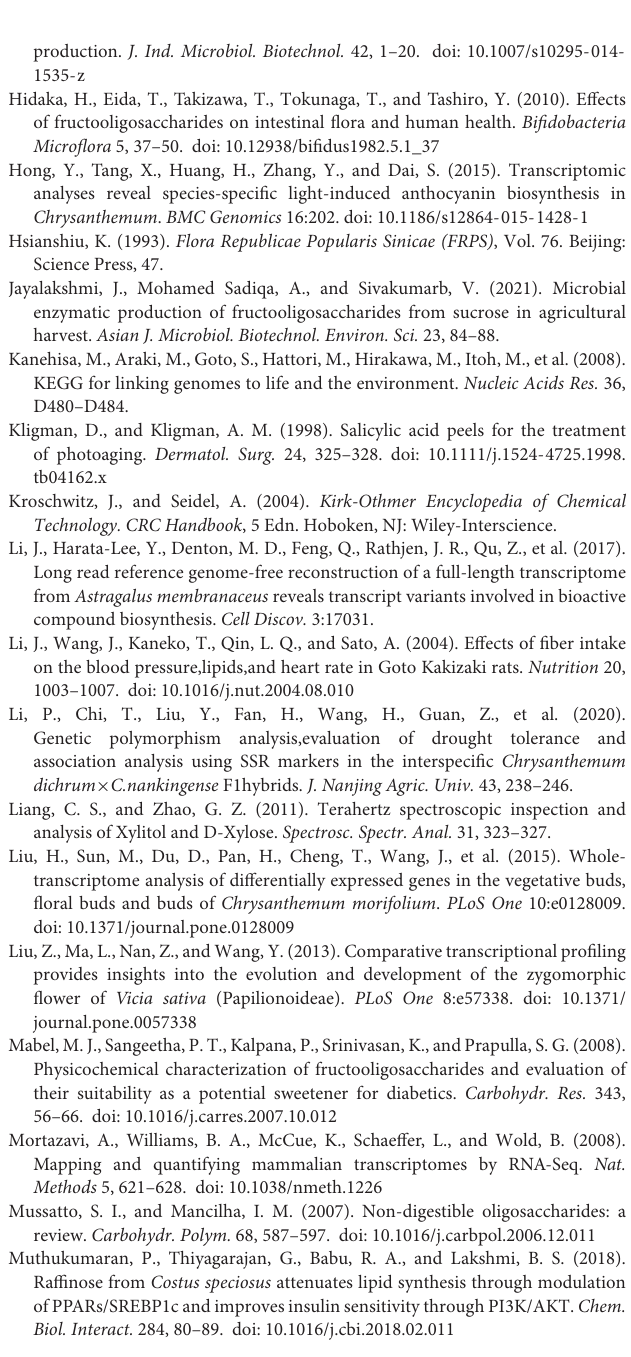
Supplementary Table 11 | Enriched KEGG pathways among the significantly down-regulated differentially expressed genes between Chrysanthemum dichrum leaves and blooming flowers. Supplementary Table 14 | Annotation of metabolic pathways common to all genes and